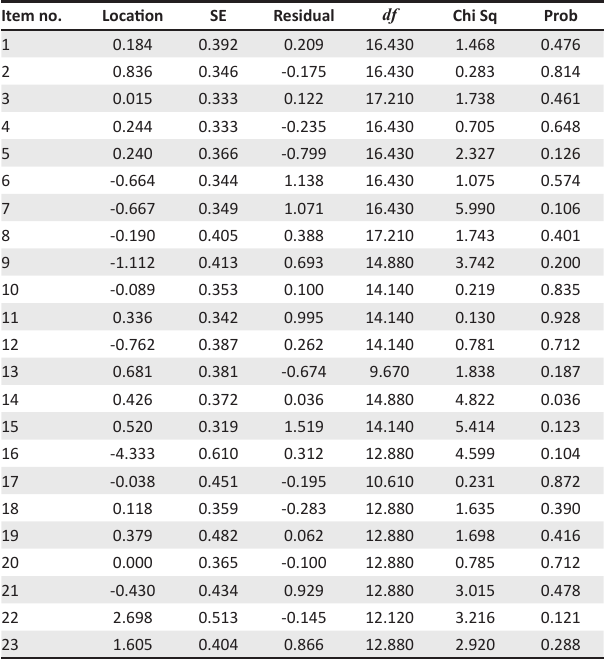
TABLE 5: Item location, standard error and fit residuals. Item no. Location